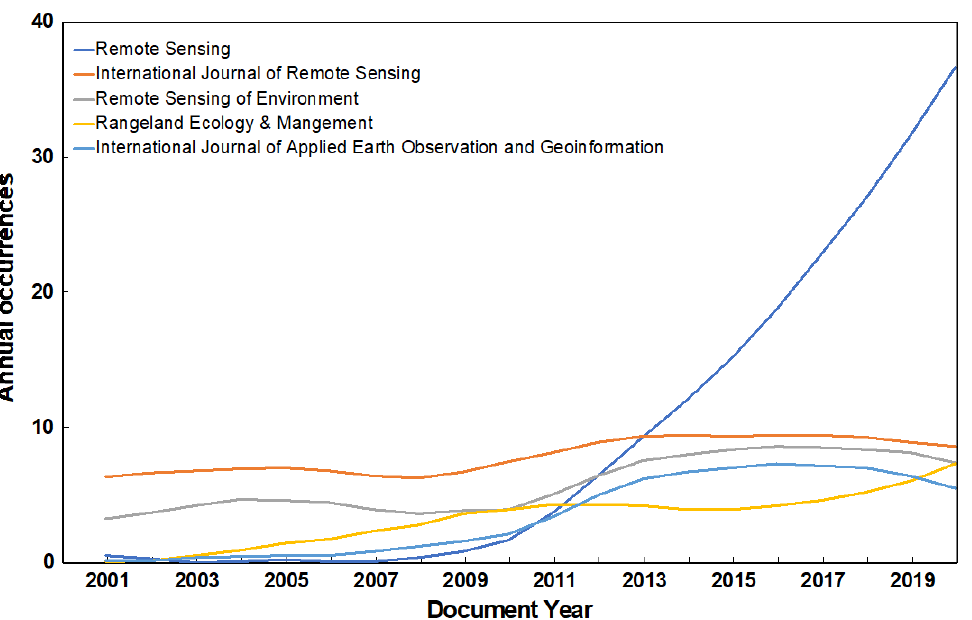
Figure 4. Journal dynamics analysis on GRS research. Table 3. Top 20 journals ranked by the total local citation score (TLCS) in GRS research from 1980 to 2020.